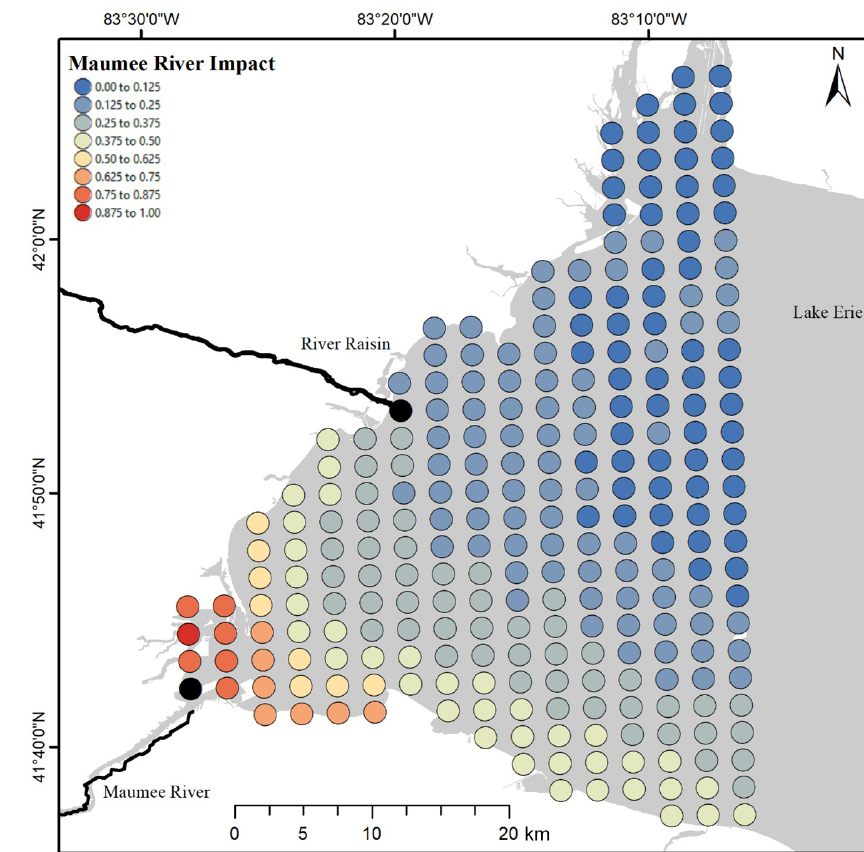
Figure 3. Heatmap of the mean Maumee River impact plume from 2008 to